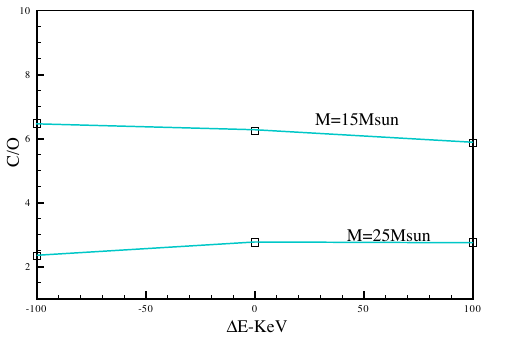
Figure 8.22: The C/O ratio and obtained Figure 8.23: The C/O ratio and obtained in the in the Figure 17: The C/O ratio obtained in the evolution of evolution of low mass stars ( 1 . 3 M and 5 . 0 M ) evolution of high mass stars ( 15 M high mass stars (15 M   upon a hypothetical change in the location of the change in the location of the resonance in 12 resonance in 12 C .